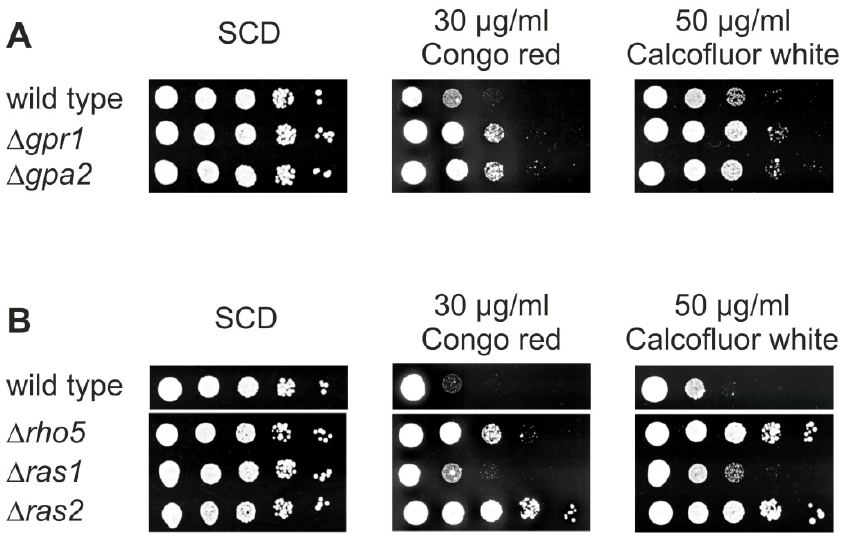
Figure 5. The lack of either Rho5, Ras2, Gpa2, or Gpr1 cause hyper-resistance towards cell wall stress agents. ( A , B ) Ten-fold drop dilution assays, from left to right, were performed on the media as indicated with haploid deletion strains as indicated. Strains used are described in Materials and Methods and in Table 1.